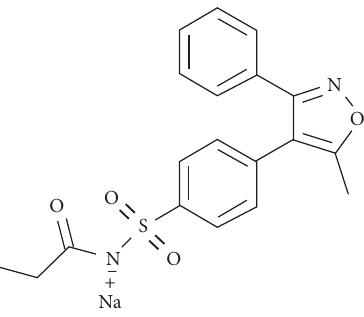
Figure 1: Structure of parecoxib